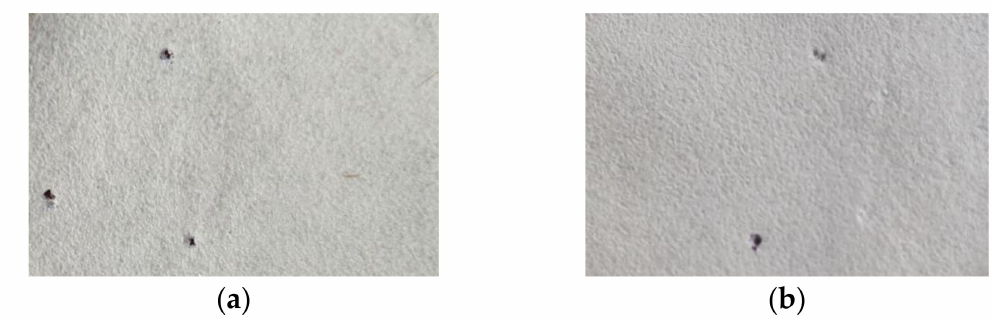
Figure 25. Paper condition after breakdown tests: ( a ) Kenaf paper with weight percentage concentration of 3% of PVA and ( b ) Kenaf paper with weight percentage concentration of 6% of